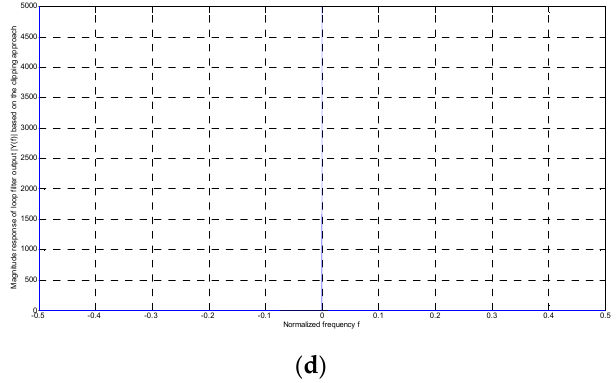
≥ k = ku for 0 under our proposed control ≥ k = ku for 0 under the clipping strategy 0 ≥ k = ku for under